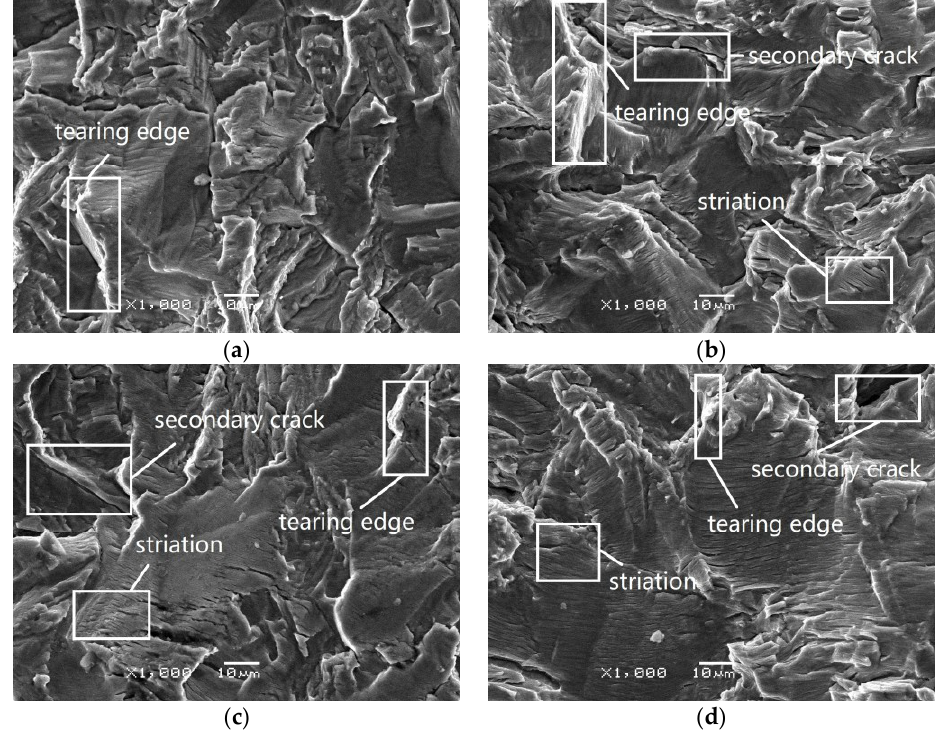
Figure 16. Typical SEM micrographs showing dwell fatigue fracture surface morphology at different temperatures under high load ratio: ( a ) initial stage, room temperature; ( b ) initial stage, T = 300 ◦ C, ( c ) steady stage, room temperature; ( d ) steady stage, T = 300 ◦